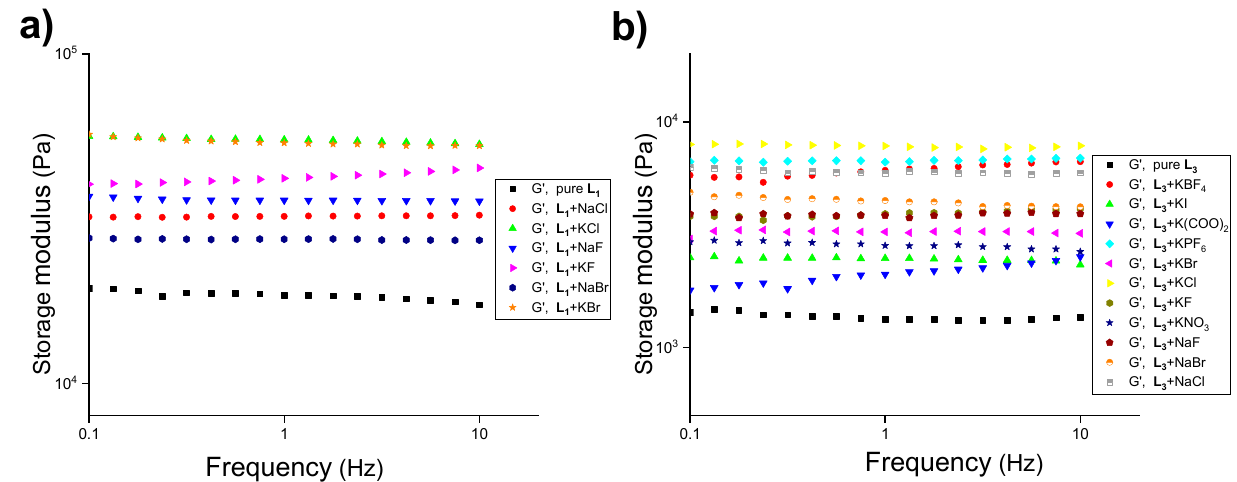
Figure 5. Frequency-sweep experiments of L 1 and L 3 at 1.5 wt% in water at 20.0 °C in the presence of various salts of sodium and potassium (1.0 equiv.) with a constant strain of 0.02%, ( a ) L 1 (pure ligand at 1.8 wt%), and ( b ) L 3 (pure ligand at 1.8 wt%).